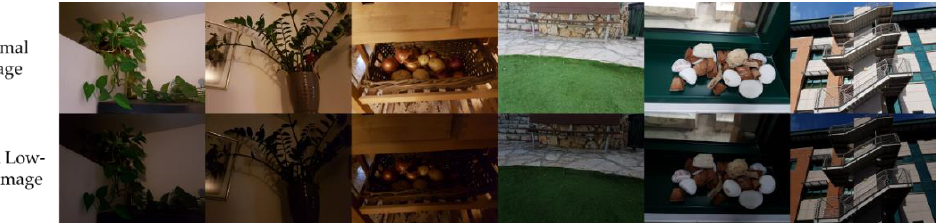
Figure 2. The representative images of DeepISP of every type [36]. UCMerced: It is composed of 21 types of land use images secondarily processed based on United States Geological Survey (USGS) National Map with a pixel resolution of one foot. Each category has 100 images of 256 × 256 pixels. Figure 3 shows some representative images of UCMerced datasets. This dataset is named Dataset2.